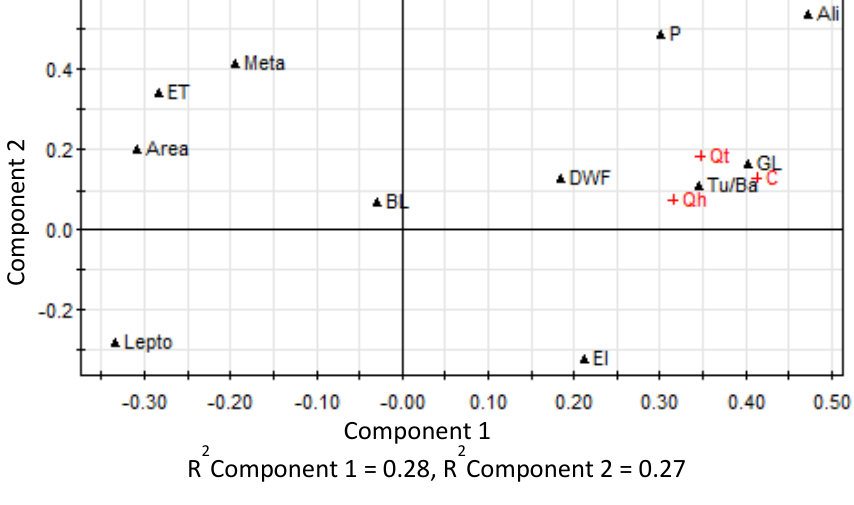
2 R Component 1 = 0.28, R